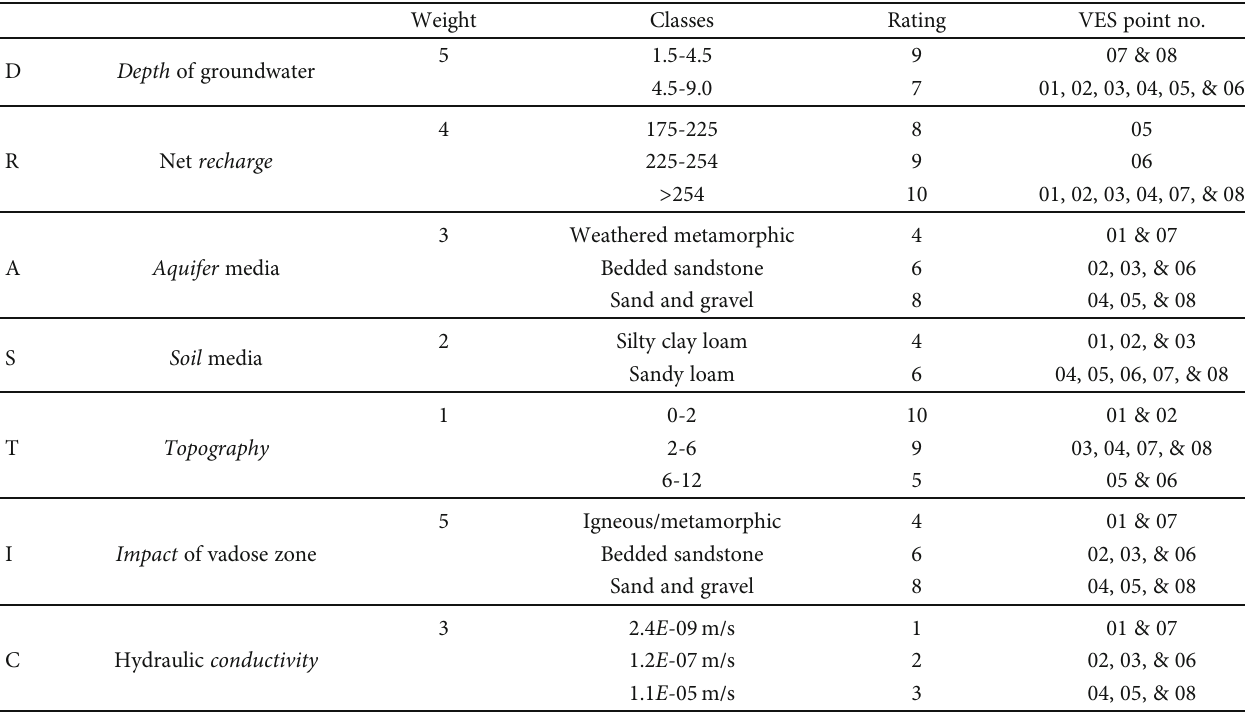
Table 11: Resume of DRASTIC